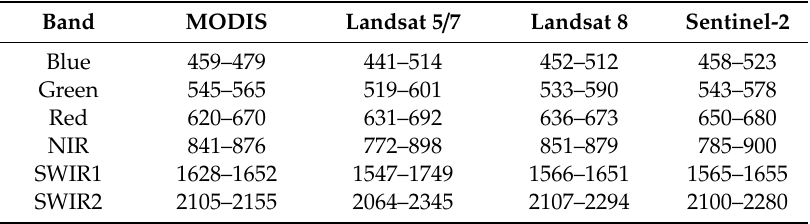
Table 1. Band wavelengths (nm) of MODIS, Landsat 5 / 7 / 8, and Sentinel-2 satellite